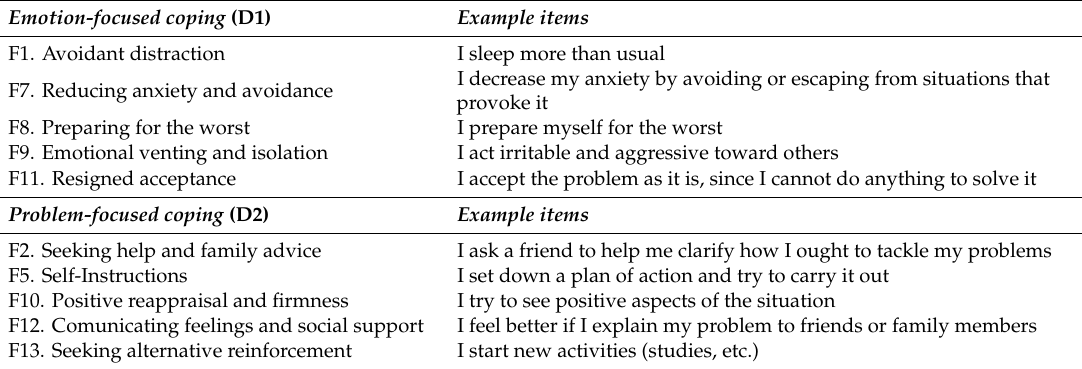
Table 1. Types of Coping Strategies and Examples of Items in the Short EEC version